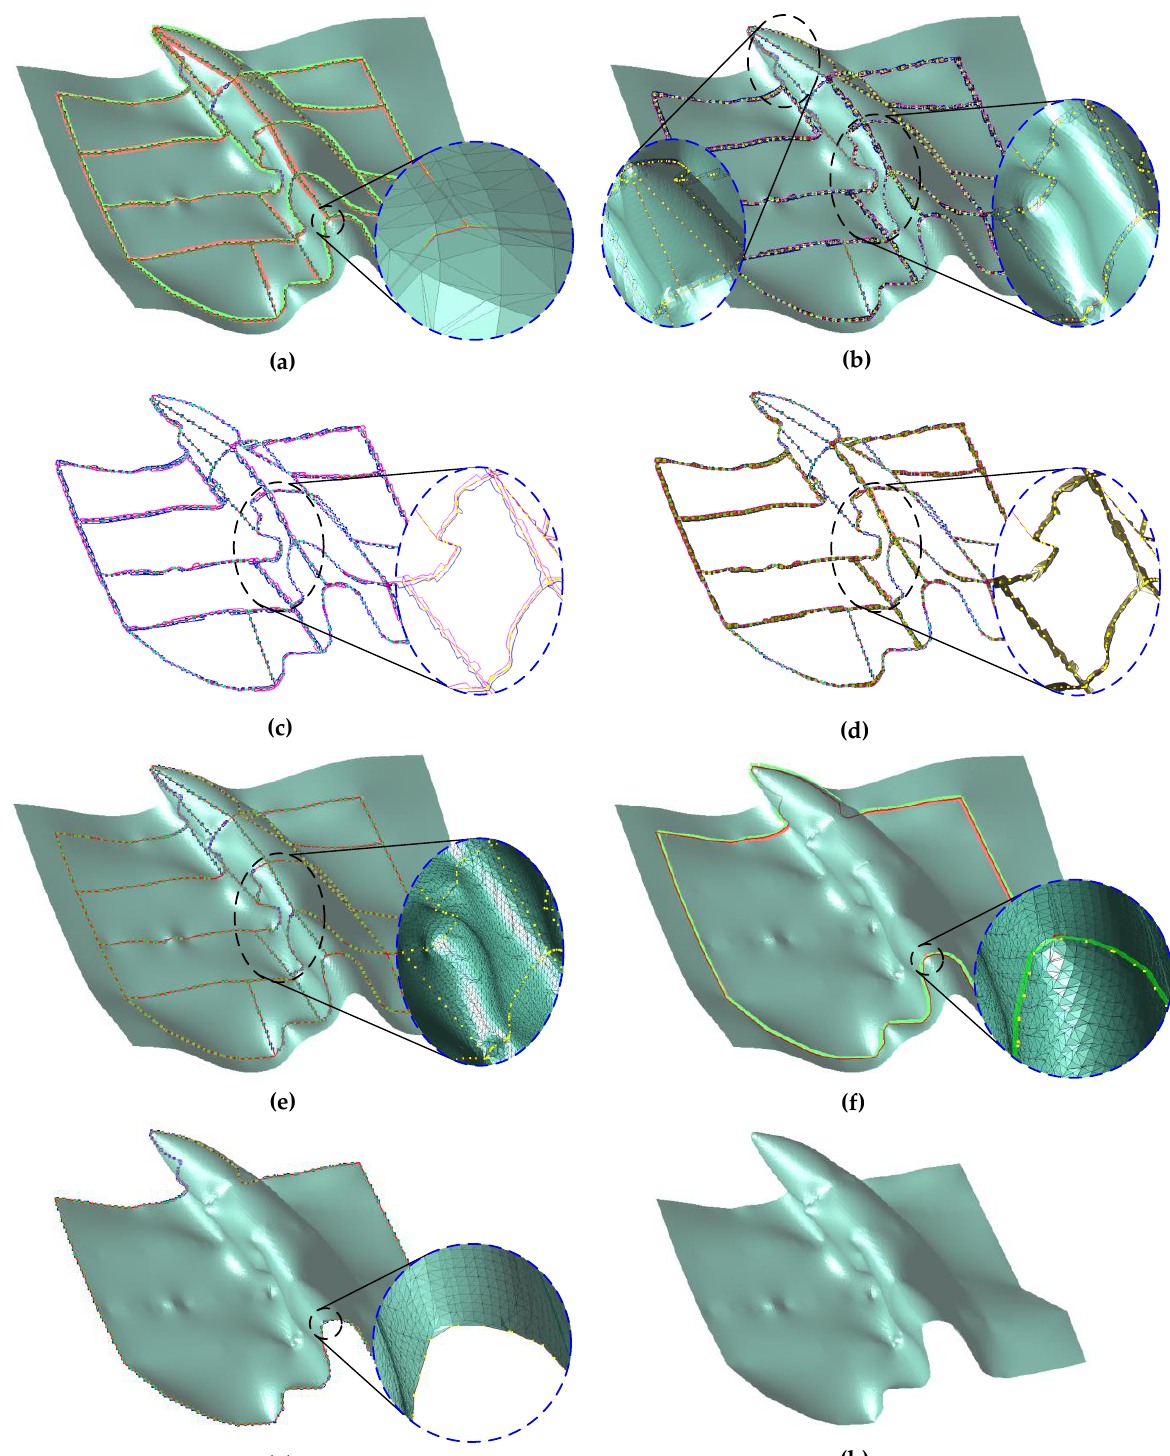
Figure 14. The fourth group test results of the snapping of feature polylines and the clipping of the model boundary. ( a ) shows constraint polylines and implicit modeling results. ( b ) shows the process of constraint polyline projection and mesh matching. ( c ) shows the matched mesh boundaries. ( d ) shows the re-meshing of the matching meshes. ( e ) shows the results of mesh merging and normal consistency. ( f ) shows the boundary constraint polylines and the model after normal consistency. ( g ) shows the result of mesh boundary clipping. ( h ) shows the orebody model after mesh processing.